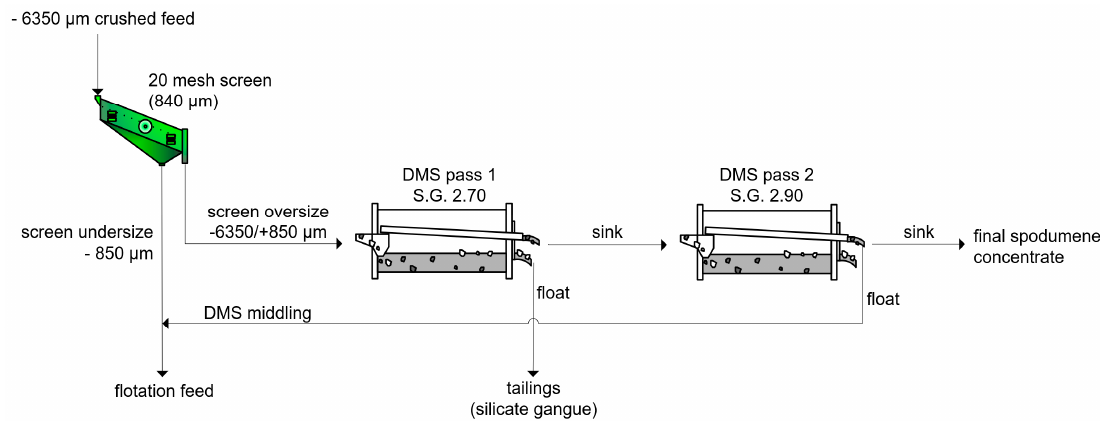
Figure 9. DMS circuit flowhseet.